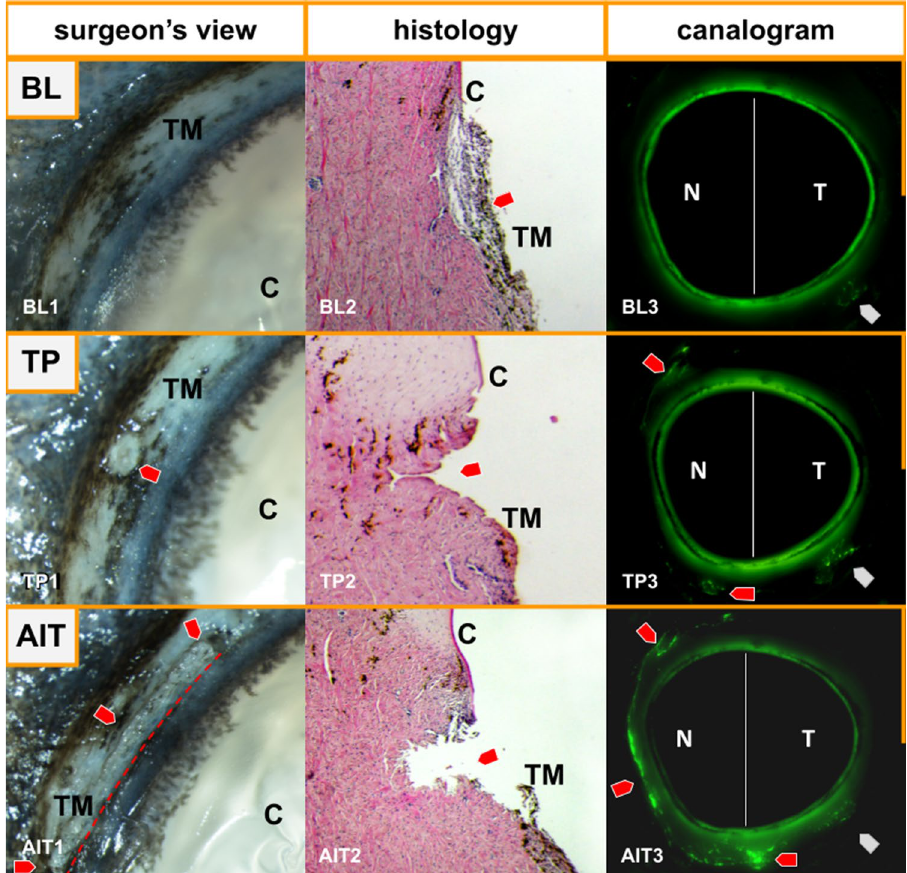
Figure 1. Visualization of the effects of trabeculopuncture (TP) and ab interno trabeculectomy (AIT). Microscopic images, histology sections, and canalograms at baseline (BL), after trabeculopuncture (TP), and after ab interno trabeculectomy (AIT). BL1: Microscopic image of the porcine trabecular meshwork at baseline. BL2: Histological analysis of a section of the intact porcine TM (red arrow). BL3: Canalogram image of an anterior segment perfused with fluorescent spheres. No sphere collection can be seen in the nasal episcleral veins at baseline. Single beads were detected in the temporal region (gray arrow). TP1: Ex vivo image of a nasal YAG-TP. TP2: Histological analysis of a section after TP on the TM (red arrow). TP3: Canalogram image of an anterior segment perfused with fluorescent spheres after TP. Fluorescent spheres can now be visualized in the nasal episcleral veins (red arrows). Temporal fluorescence remained unchanged from baseline (gray arrow). AIT1: Image post trabeculectomy. The red arrows outline the excision in the TM. AIT2: Histological section after AIT. The trabecular meshwork is excised (red arrow). AIT3: Canalogram image of an anterior segment perfused with fluorescent spheres. An increased accumulation of spheres along the nasal circumference can be seen (red arrows). TM = trabecular meshwork; C = cornea; N = nasal; T = temporal.